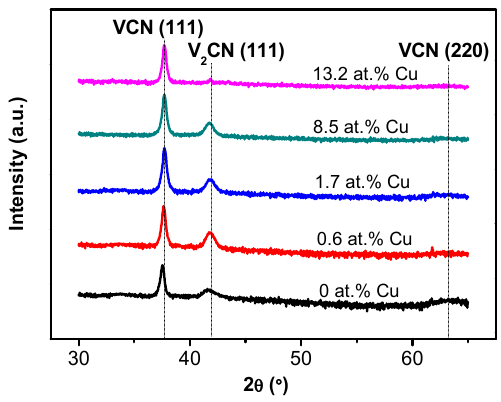
Figure 1. X-ray diffraction (XRD) patterns of VCN–Cu films with different Cu contents.